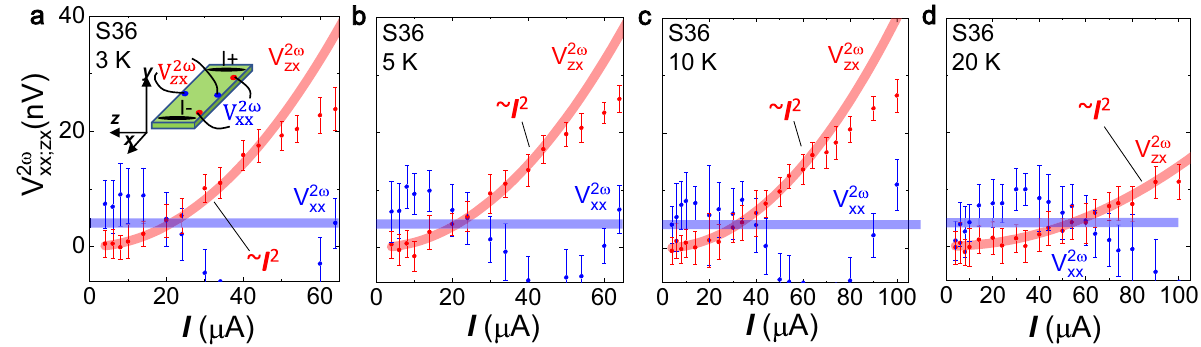
Fig. 2 Temperature dependence of the nonlinear Hall effect. a – d Temperature-dependent 2 ω signals in longitudinal and transverse con fi gurations, respectively. Inset shows the contact layout and de fi nition of crystal axes. The nonlinear Hall signal is proportional to the square of excitation current as indicated by shadowed fi tting lines, while the longitudinal signals are almost unchanged as indicated by the blue-shadowed lines for eye-guide. The error bars represent the standard deviation of the measured